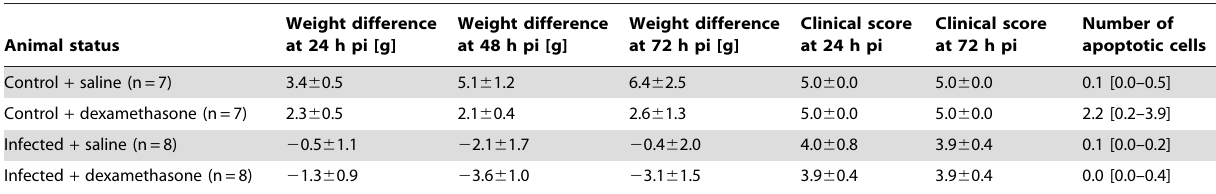
Table 1. Overview of the clinical parameters of all experimental groups.